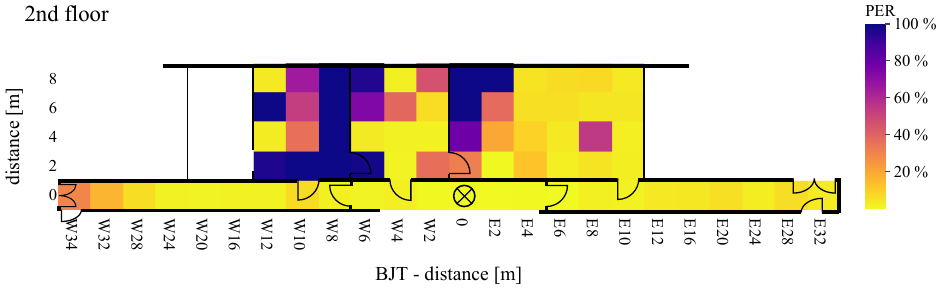
Figure 21. Packet error rate of BJT board with WuRx and WuTx on the same floor.